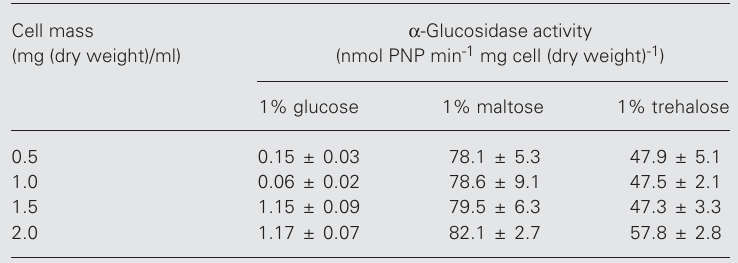
Table 4. α -Glucosidase activity during growth of Candida utilis in glucose, maltose and